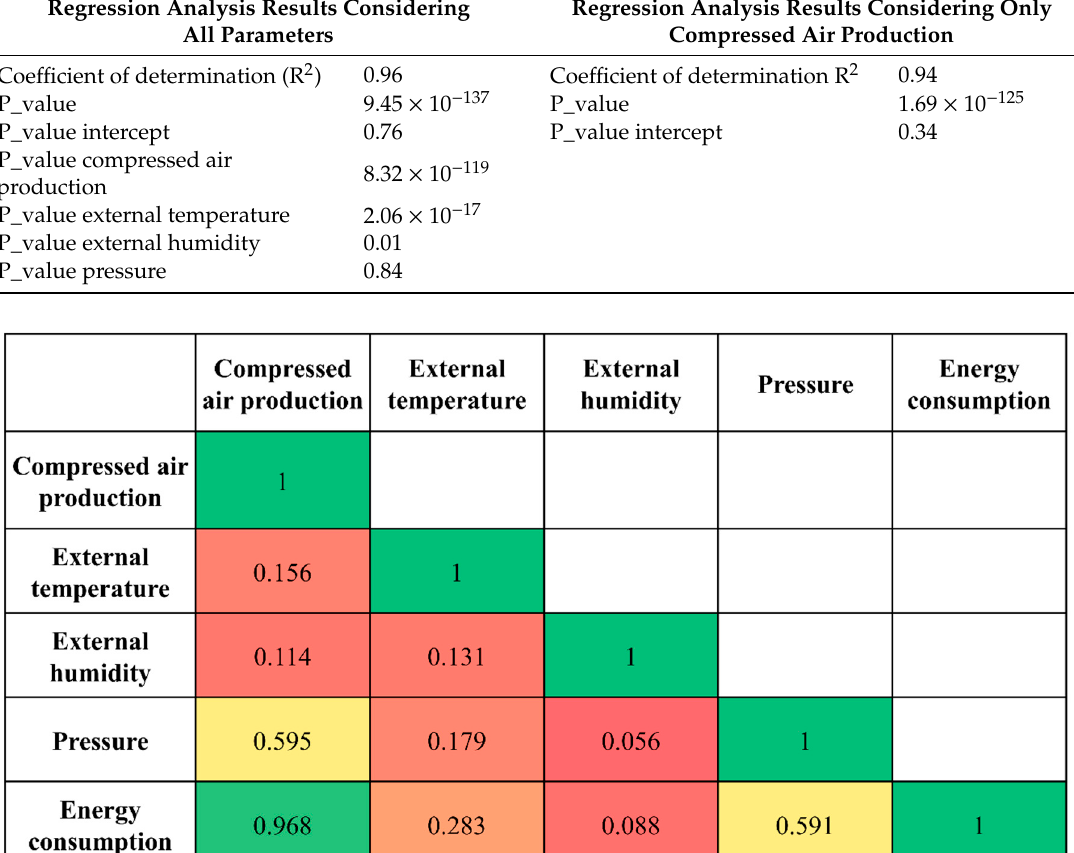
Figure 7. Correlation matrix. The color scale represents the value of the correlation between two variables: green highlights strong correlations while red highlights weak correlations.